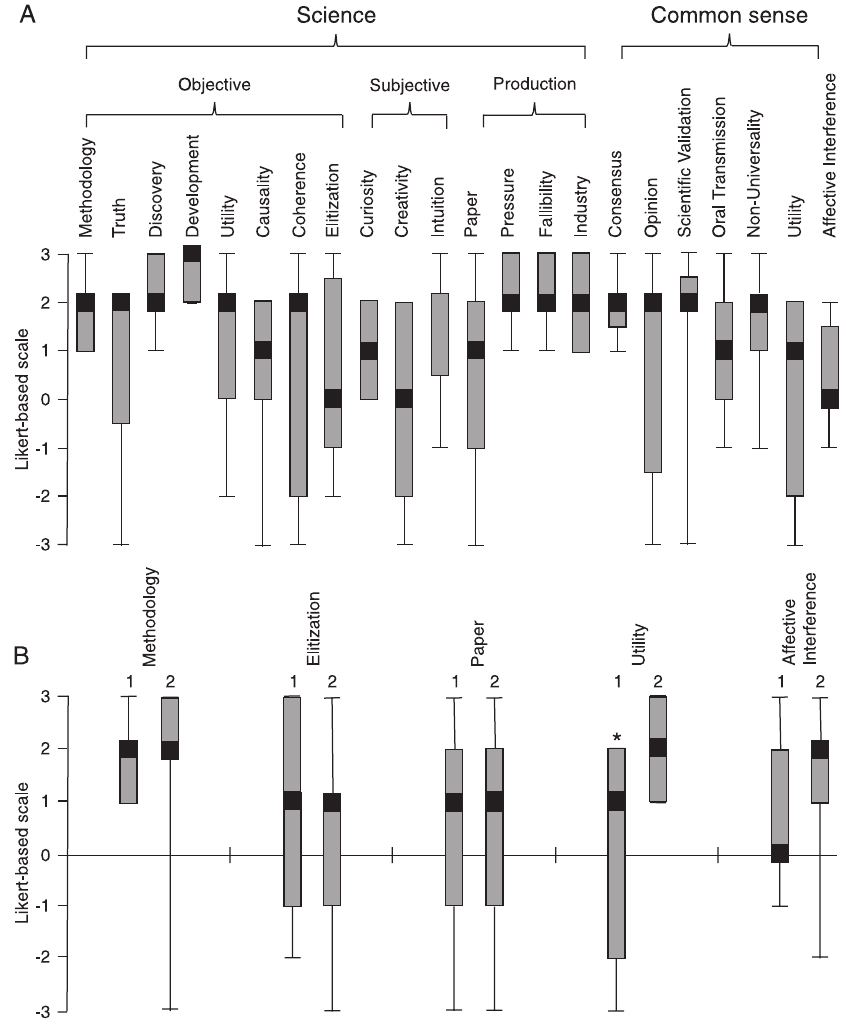
Figure 3. Extent to which MD-PhD students and physician scientists agree with classical con- cepts of science and common sense. Twenty-two classic statements about science and com- mon sense were scored by 12 students in the MD-PhD program ( Panel A and 1 in Panel B ) and 36 physician-scientists (2 in Panel B ) according to the Likert scale, which ranges from -3 (stron- gest disagreement) to +3 (strongest agreement). The results are presented as median scores (black), quartile intervals (Q 2 - Q 1 , in gray) and maximum/minimum values (lines). *P < 0.05 based on the Mann-Whitney test for comparison between MD-PhD students and physician- scientists. In Panel B , the degree of agreement between students and physician-researchers was not significantly different for the 17 concepts not shown in Panel